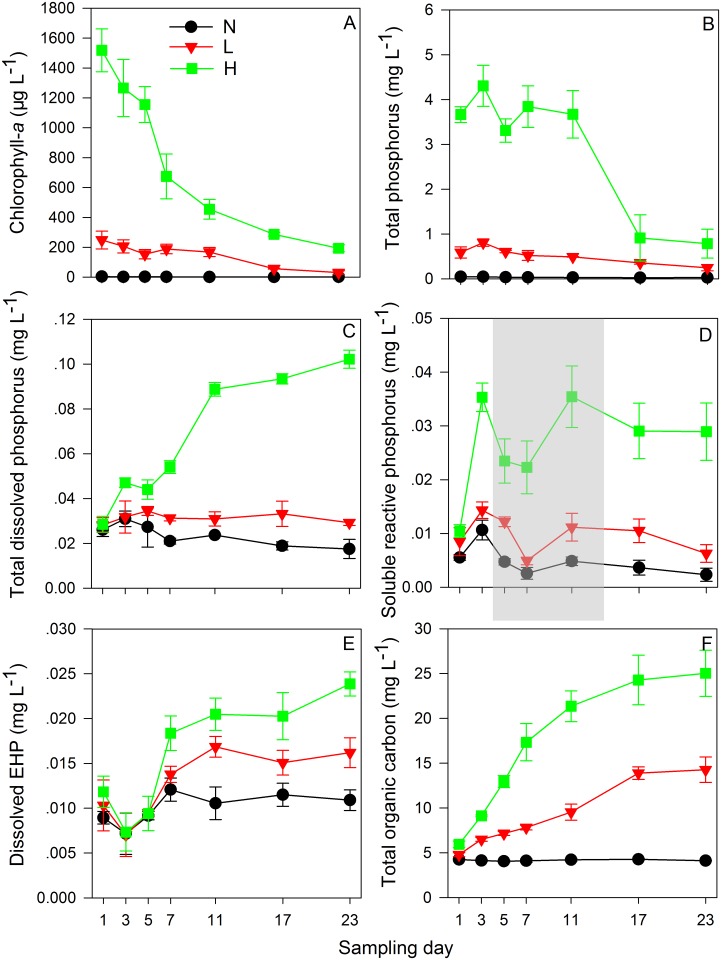
Variations in contents of chlorophyll-a (A), total phosphorus (B), total dissolved phosphorus (C), soluble reactive phosphorus (D), and dissolved enzymatically hydrolysable phosphorus (E) and dissolved organic carbon (D) in water during the simulated decomposition of Microcystis blooms.N, L and H in the legend represent the three groups with ~15, ~150 and ~1500μg L-1 chlorophyll-a, respectively. The grey shadow emphasizes the decrease trend of soluble reactive phosphorus in this experiment.